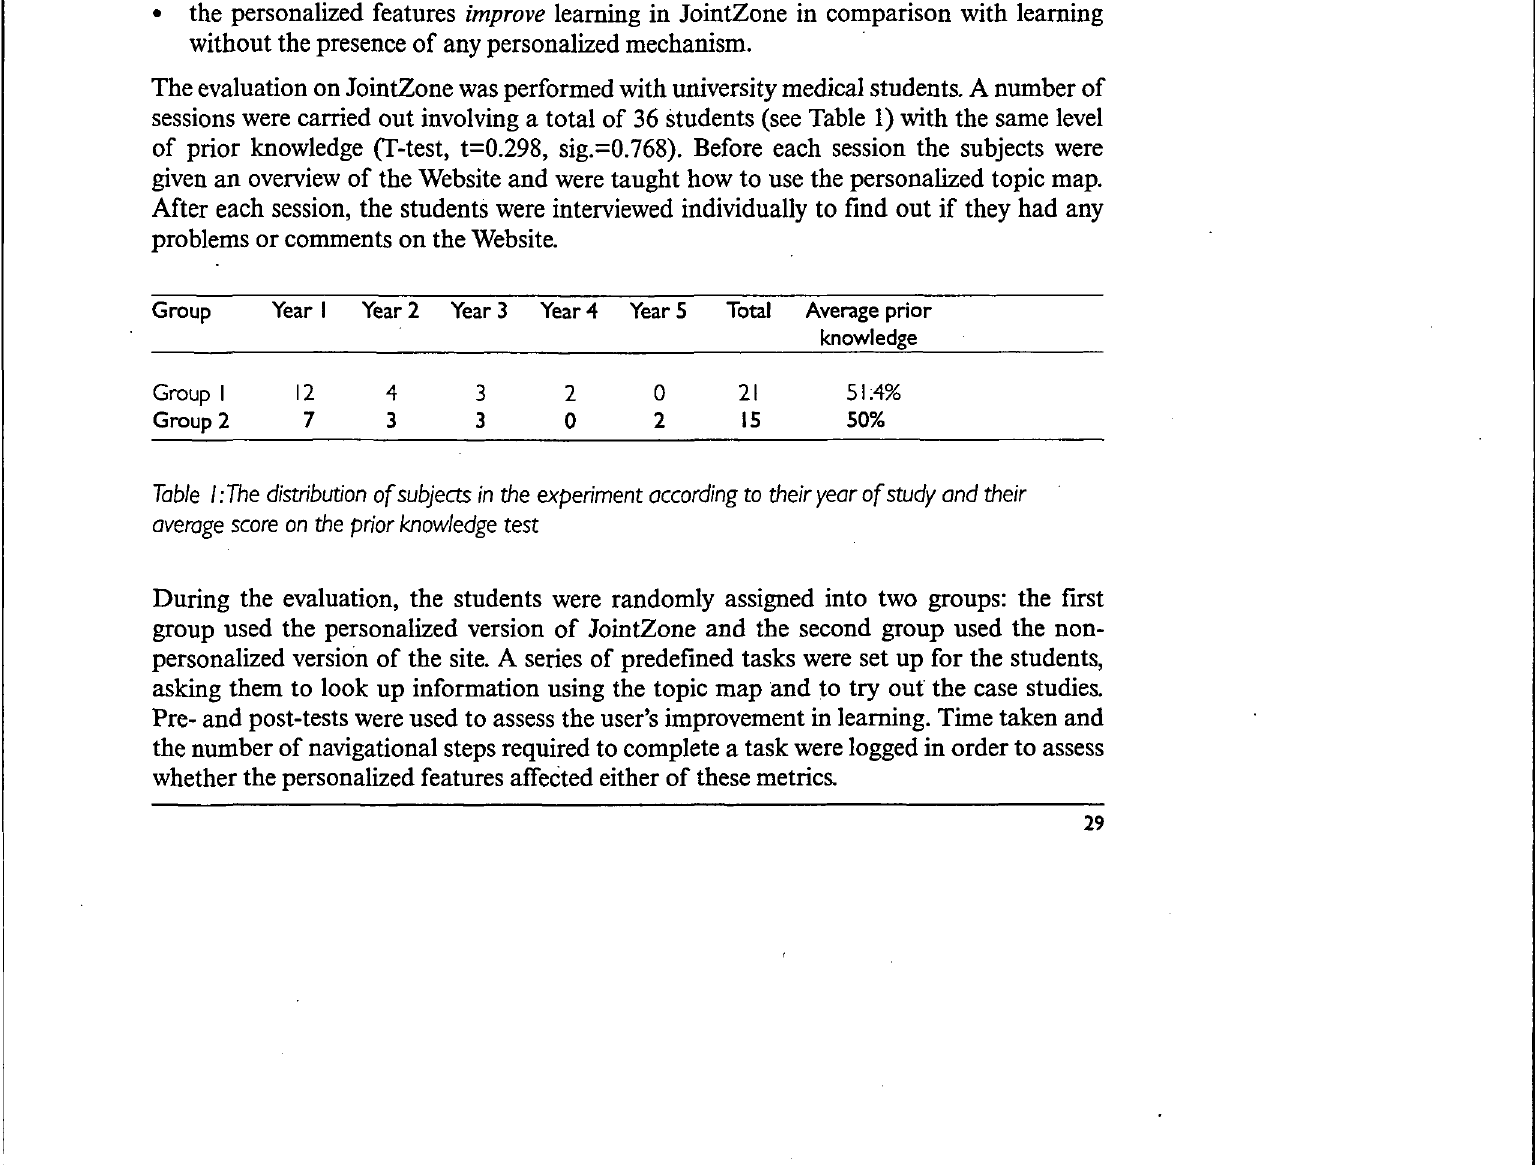
Table I :The distribution of subjects in the experiment according to their year of study and their average score on the prior knowledge